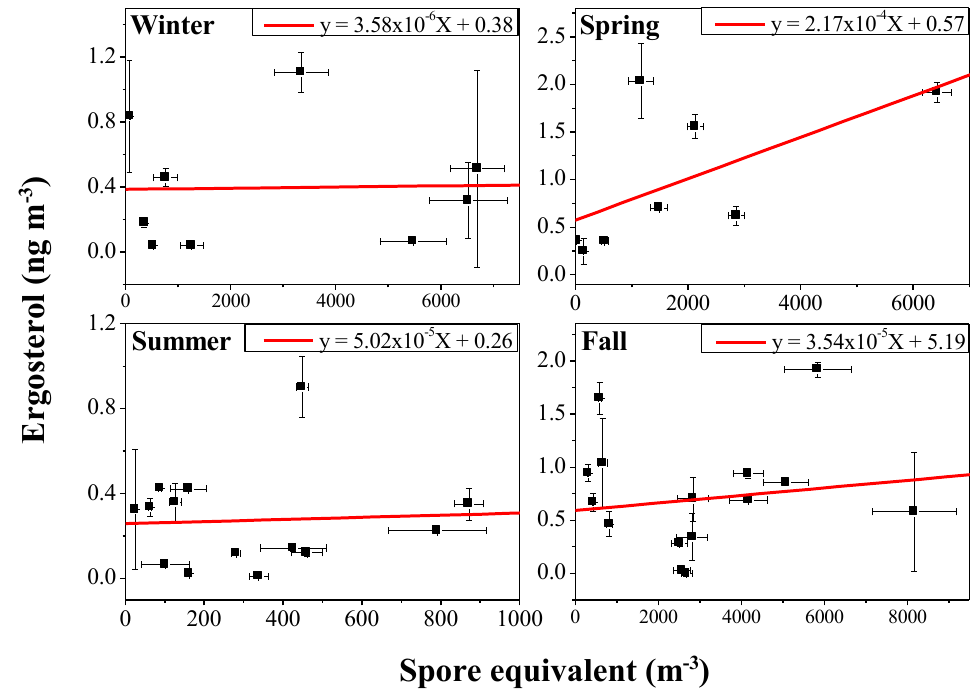
Fig. 3. Seasonal correlation between equivalent total fungal spore concentrations analyzed from q-PCR measurements, and ergosterol mass concentrations (Burshtein et al., 2011). The error bars represent the standard deviation of ergosterol (vertical) and fungi spore sampling replicates